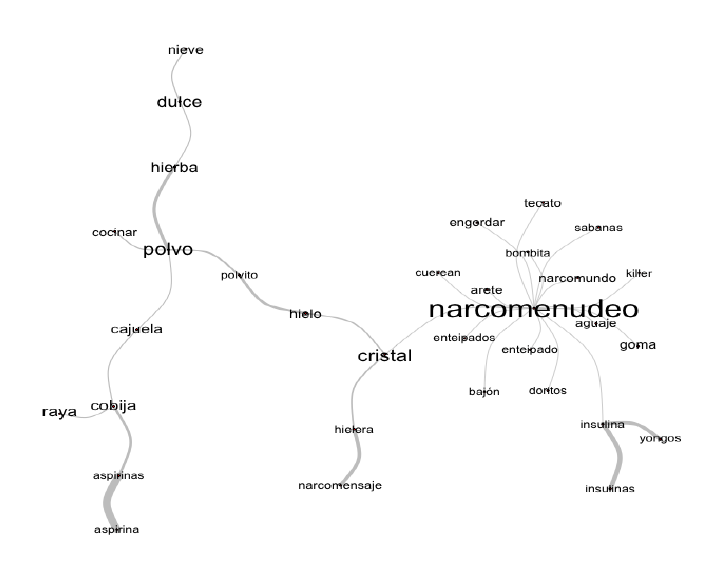
Figure 2. Sample of semantic relatedness for some triggers of figurative